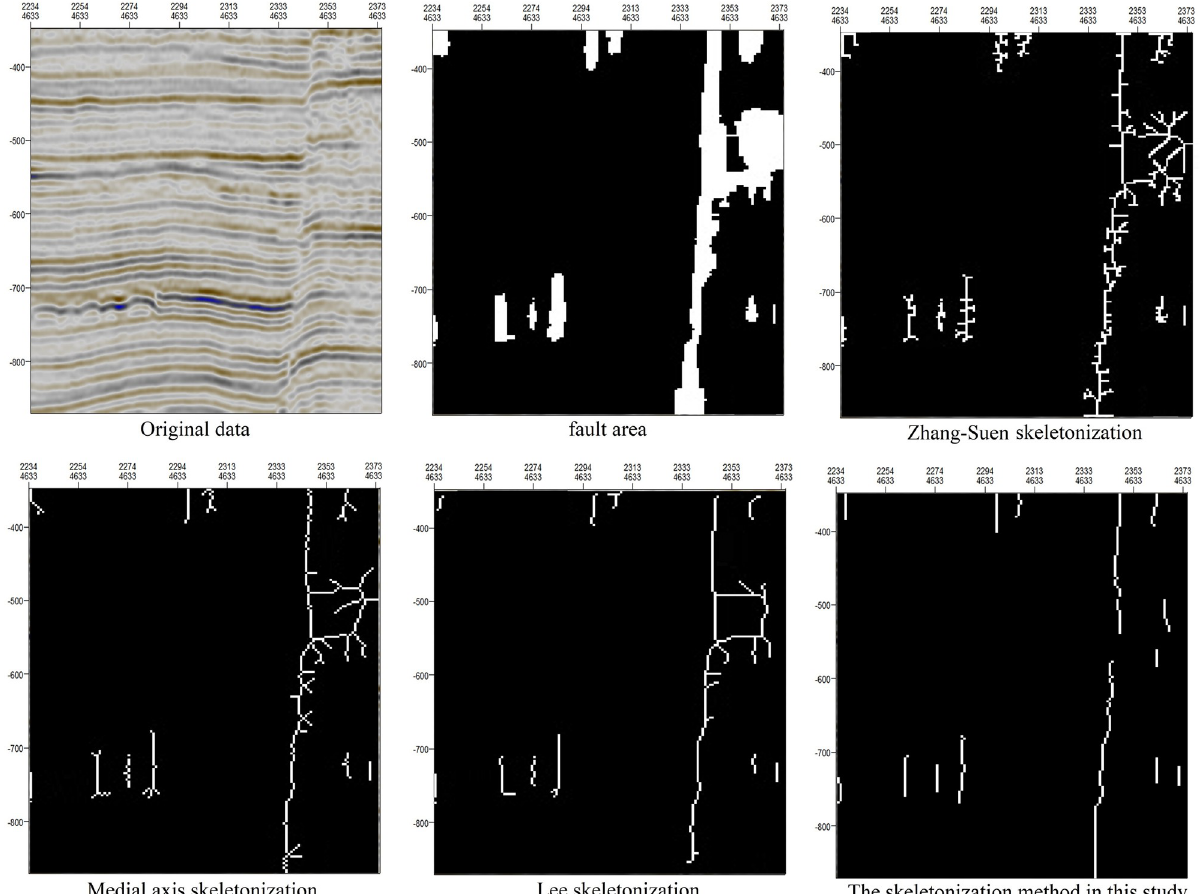
Fig 12. Comparison of different skeletonization